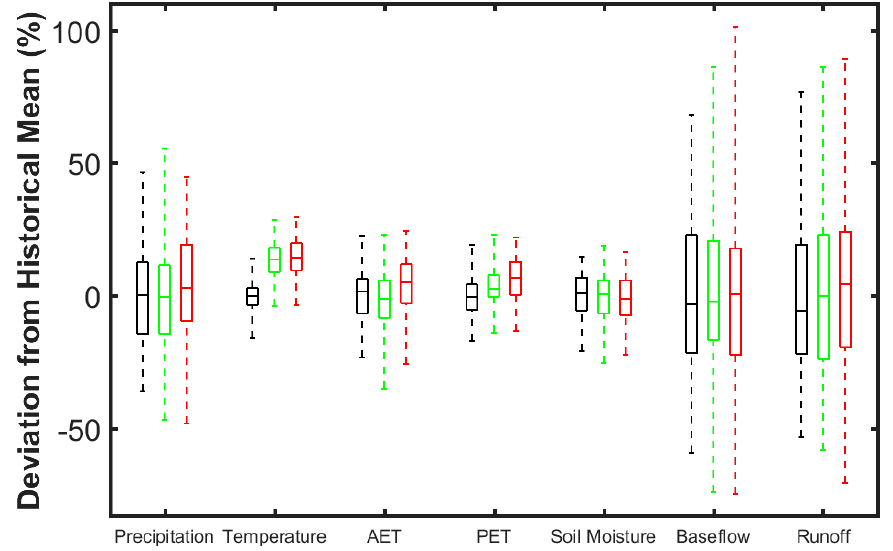
Figure 13. Box plots of average annual deviations from the historical mean for two 20-year periods of 1996–2005 (historical: black) and 2031–2050 (projected RCP 4.5: green and projected RCP 8.5: Red). Boxes are the median, 25% and 75% percentiles, and whiskers extend to the most extreme data points. The historical mean value from 1996–2005 is used as the reference.